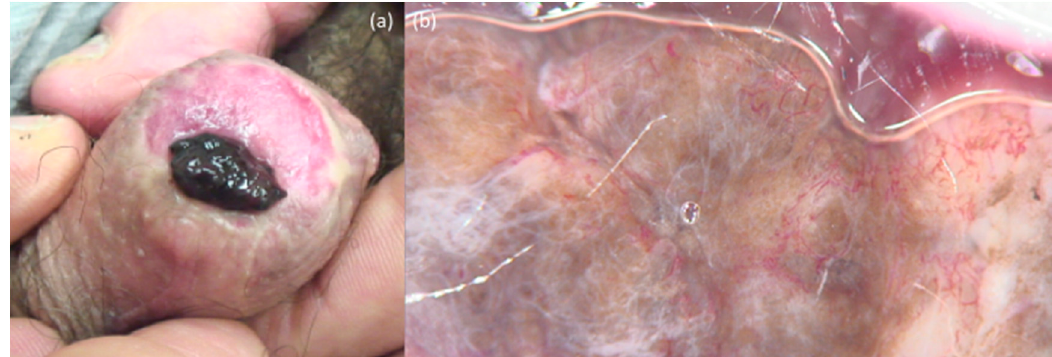
Figure 6. Penis melanoma. The clinical presentation ( a ) shows a black nodule of the glans. Dermoscopy ( b ) reveals polymorphous vessels with structureless brownish and white areas.